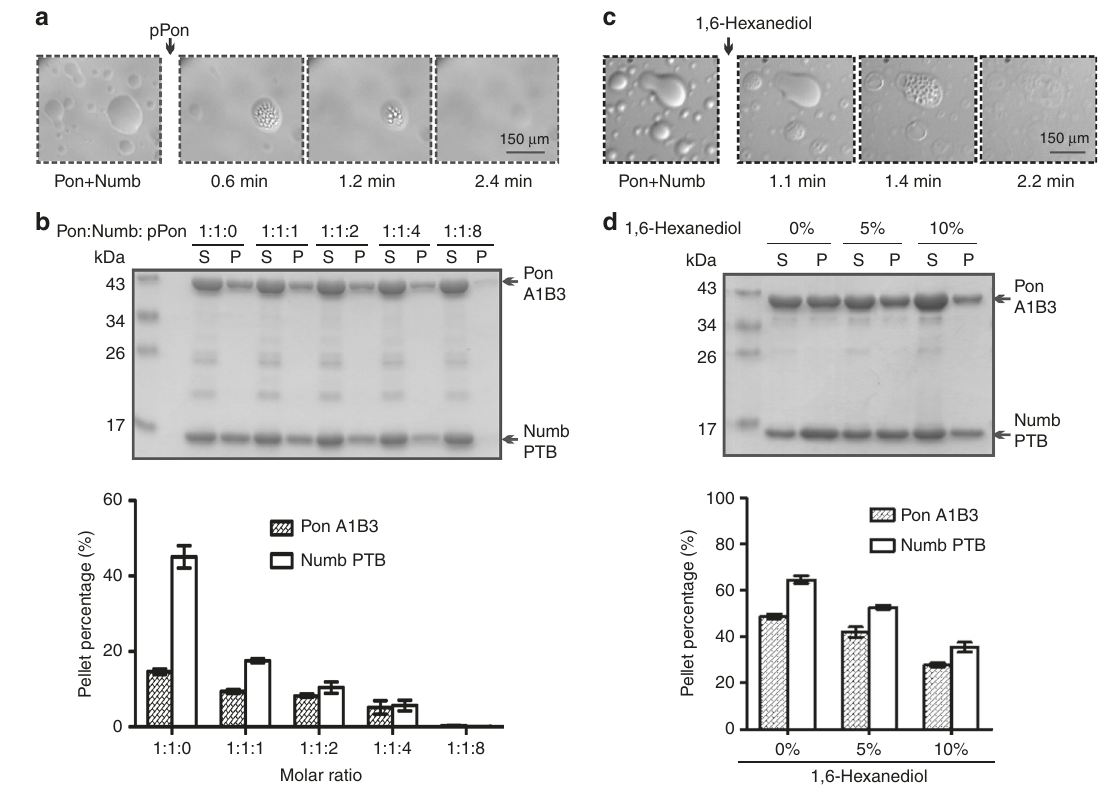
Fig. 5 The Numb/Pon phase separation assemblies can be disturbed. a Pre-formed Numb PTB (150 μ M)/Pon A1B3 (50 μ M) droplets are rapidly dispersed after adding the pPon peptide (see also Supplementary Movie 3). The arrow refers to the time point of adding the pPon peptide to the mixture. b Pre- formed Numb PTB (20 μ M)/Pon A1B3 (20 μ M) droplets can be reversed to aqueous phase by the competing pPon peptide in a dose-dependent manner. The molar ratios of Pon A1B3, Numb PTB, and pPon are indicated. c Pre-formed Numb PTB/Pon A1B3 (60 μ M) droplets are rapidly dispersed after adding 10% 1,6-hexanediol. The arrow refers to the time point of adding 1,6-hexanediol to the mixture. d Pre-formed Numb PTB/Pon A1B3 (60 μ M) droplets can be reversed to aqueous phase by 1,6-hexanediol in a dose-dependent manner. The fi nal concentration of 1,6-hexanediol is indicated. All statistic data in this fi gure represent the results from three independent batches of experiments and are expressed as mean ± SD. Uncropped gels are shown in Supplementary Fig.